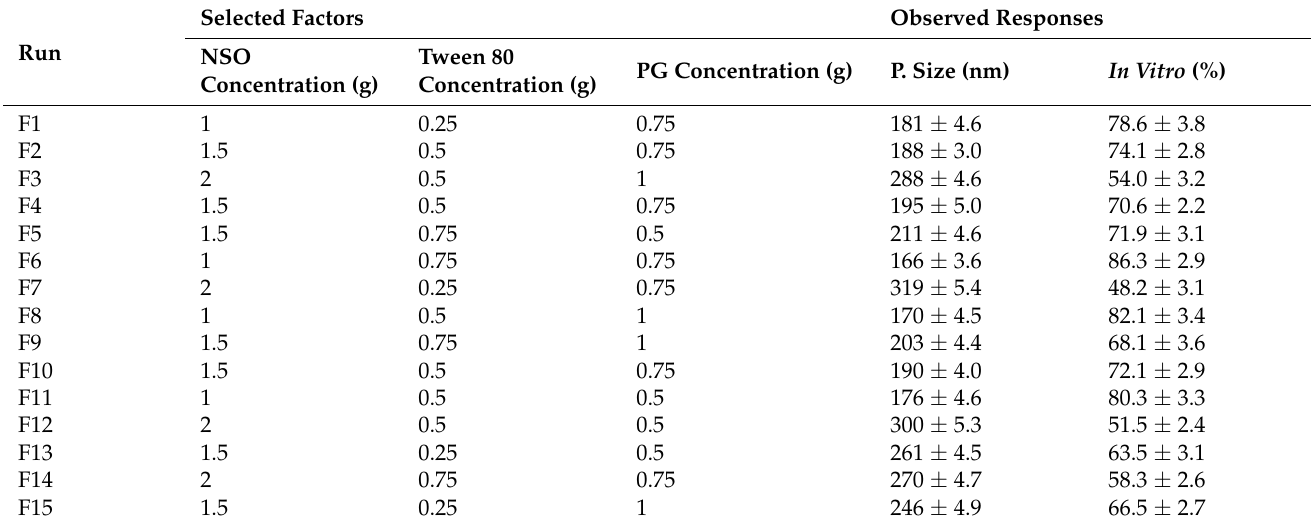
Table 2. Experimental runs and the observed responses of PGZ-loaded NE formulations using